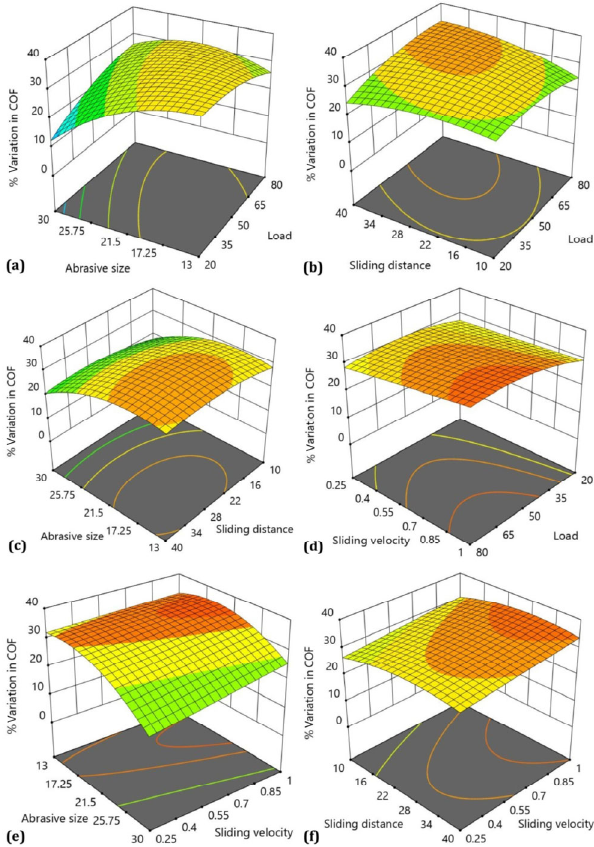
Fig. 12 Contour plots showing variations of (a) ∆ WR and (b) ∆ COF with respect to abrasive size ( μ m) and load